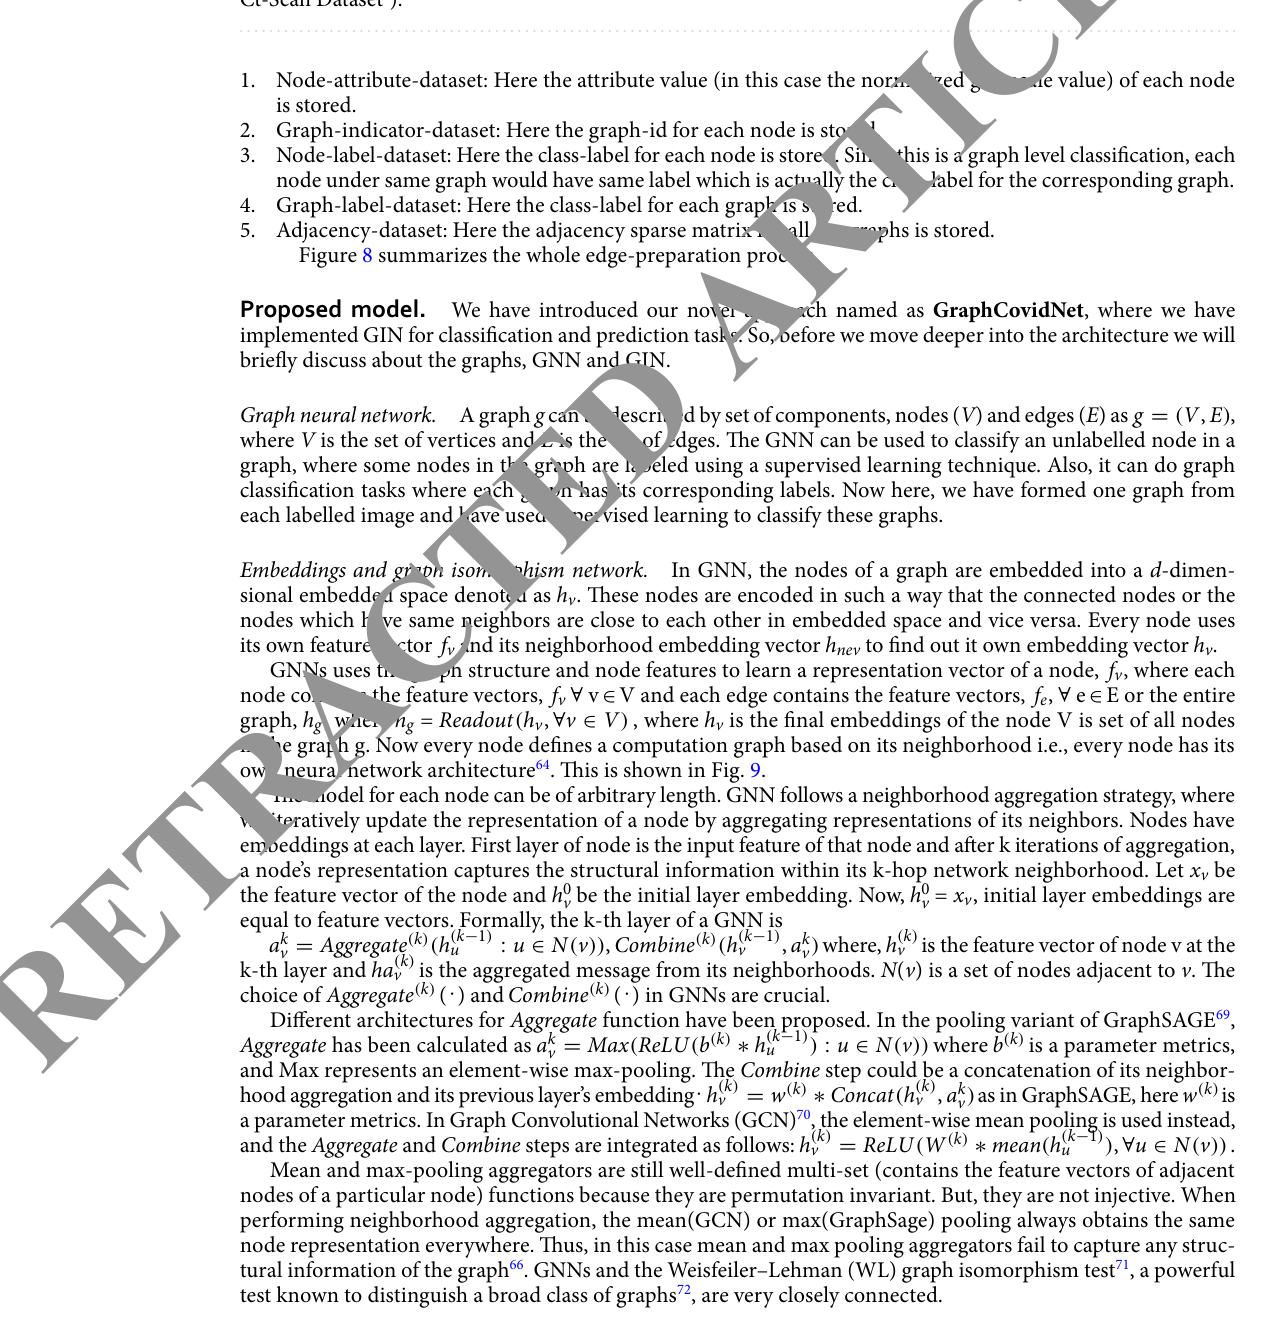
Figure 7. Diagram representing flow of edge-detection method (raw image source: CT-scan—SARS-COV-2 Ct-Scan Dataset 8